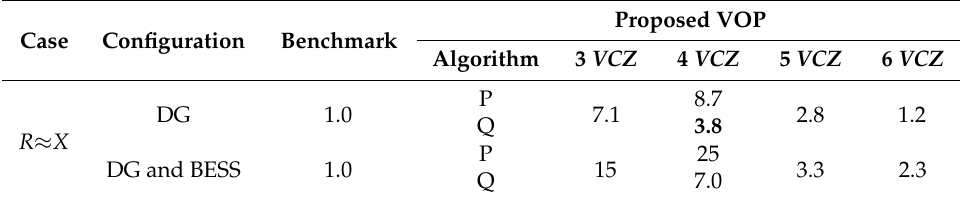
Table 12. Normalized objective functions (p.u.) for Case R ≈ X .